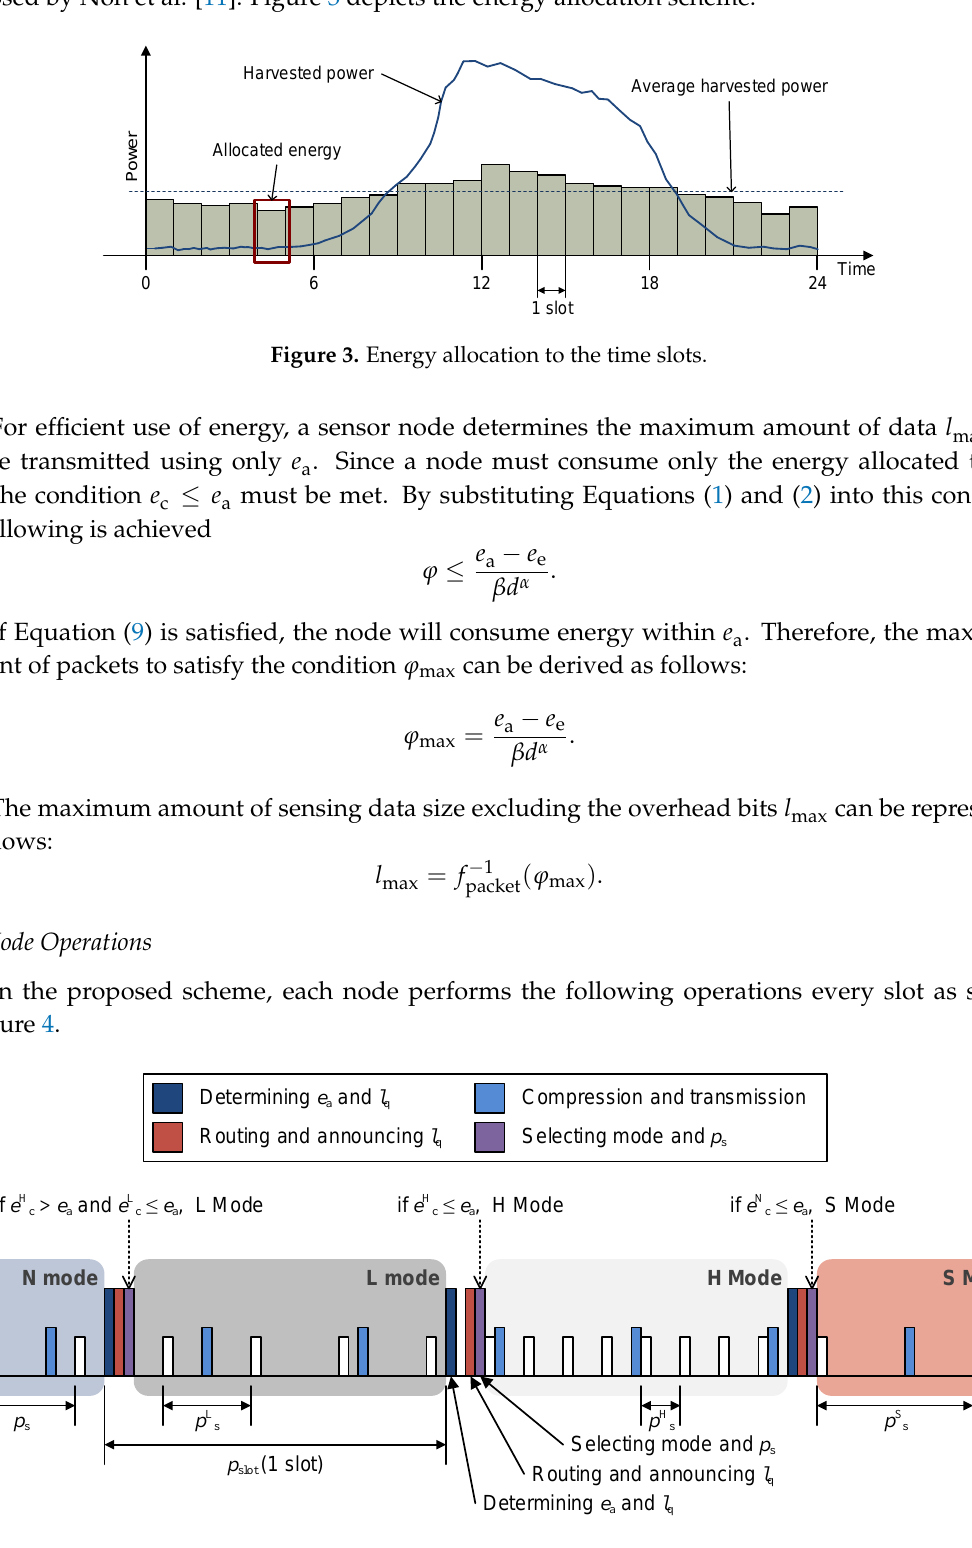
Figure 4. Operation of a node over time during two